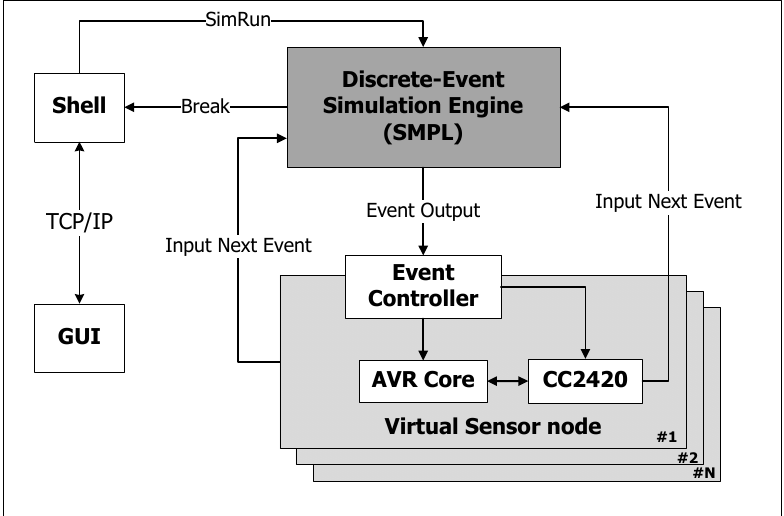
Figure 3. The architecture of a discrete-event simulator NQEM [6].